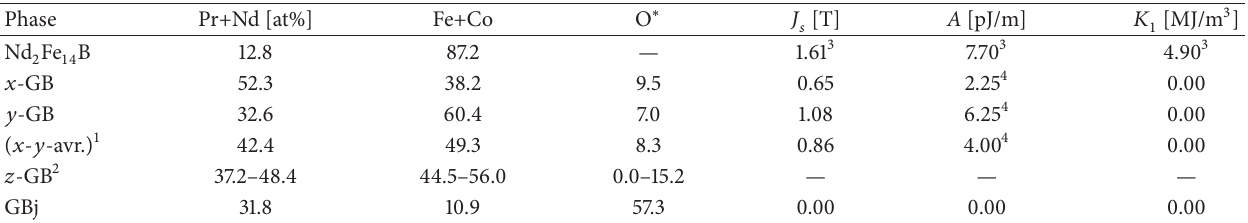
Table 2: Measured chemical composition of the occurring phases in magnet A determined by EELS and the magnetic parameters used in the micromagnetic